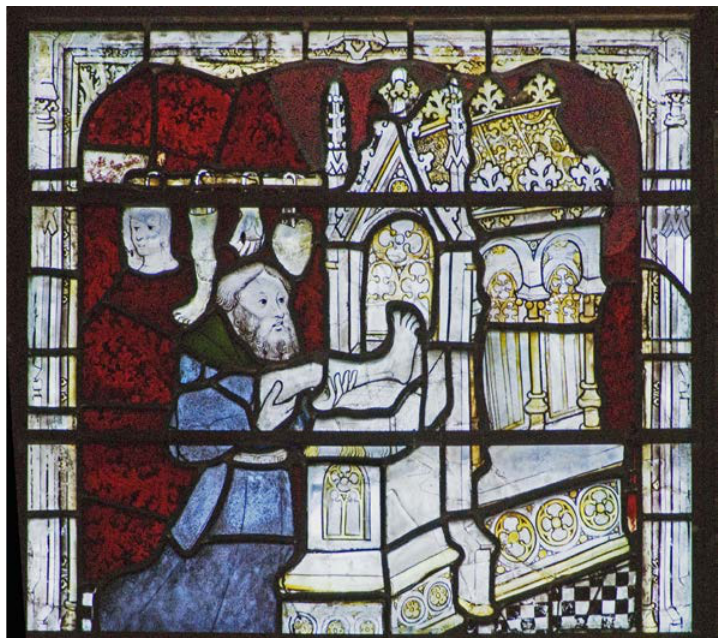
A pilgrim offering an ex voto at the Shrine of St William, from the St William Window, ca. 1414. Stained glass. York Minster. CVMA nVII 22b. © Chapter of York: reproduced by kind permission. Photo © Revd. Gordon